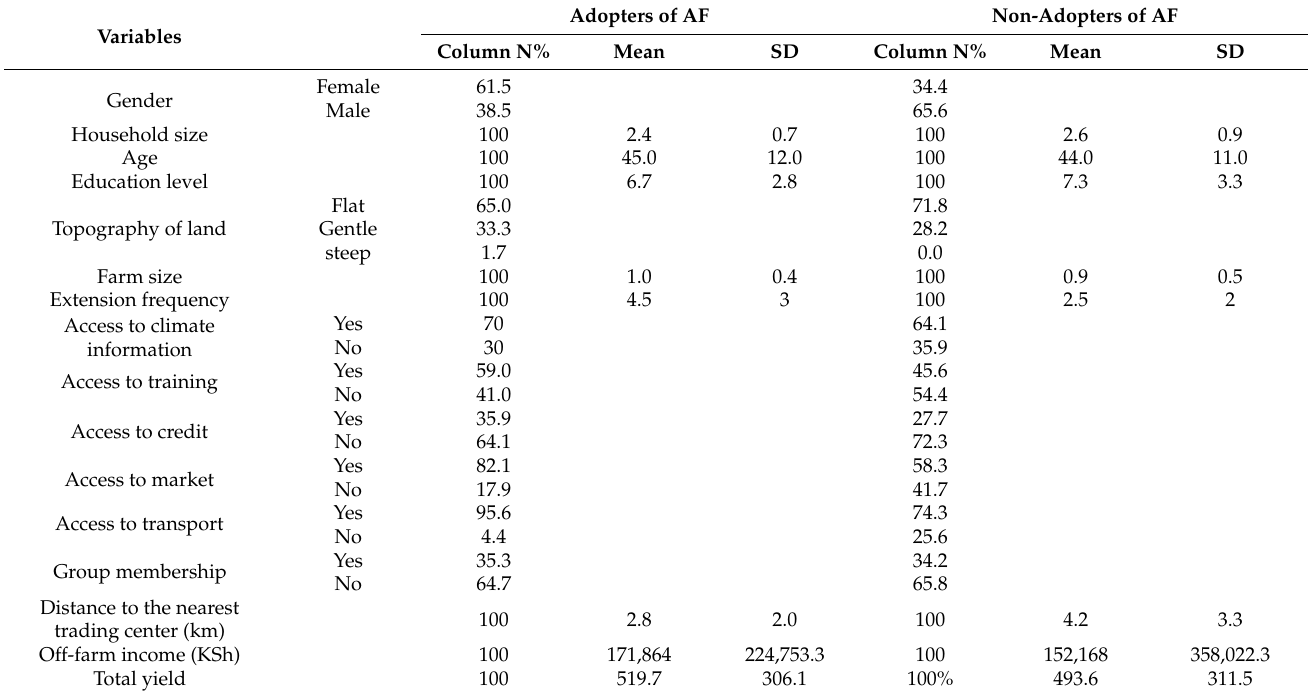
Table 2. The descriptive statistics of the adopters and non-adopters.